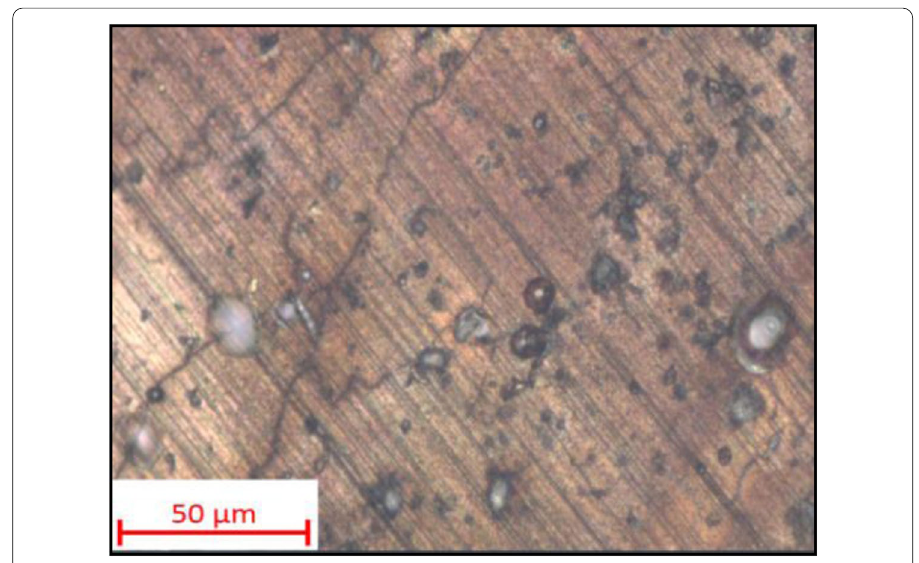
Fig. 3 Surface morphology of the alloy after S4 treatment with conversion in pH4